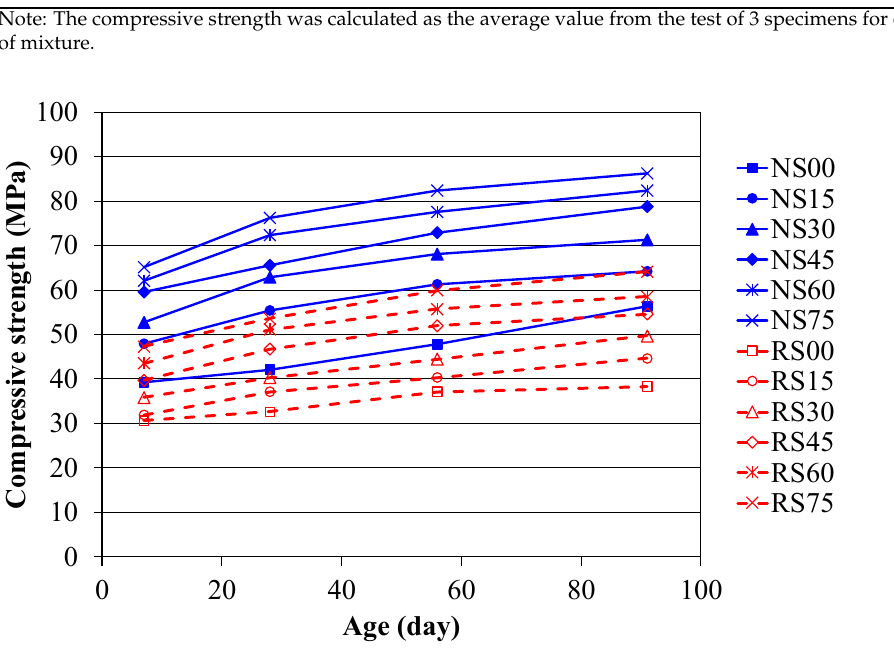
Figure 2. Compressive strength development of concrete.